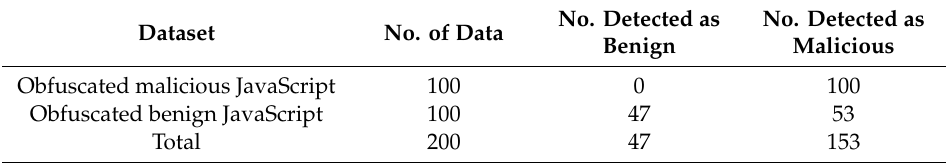
Table 7. Classification result from malicious signature inspection.